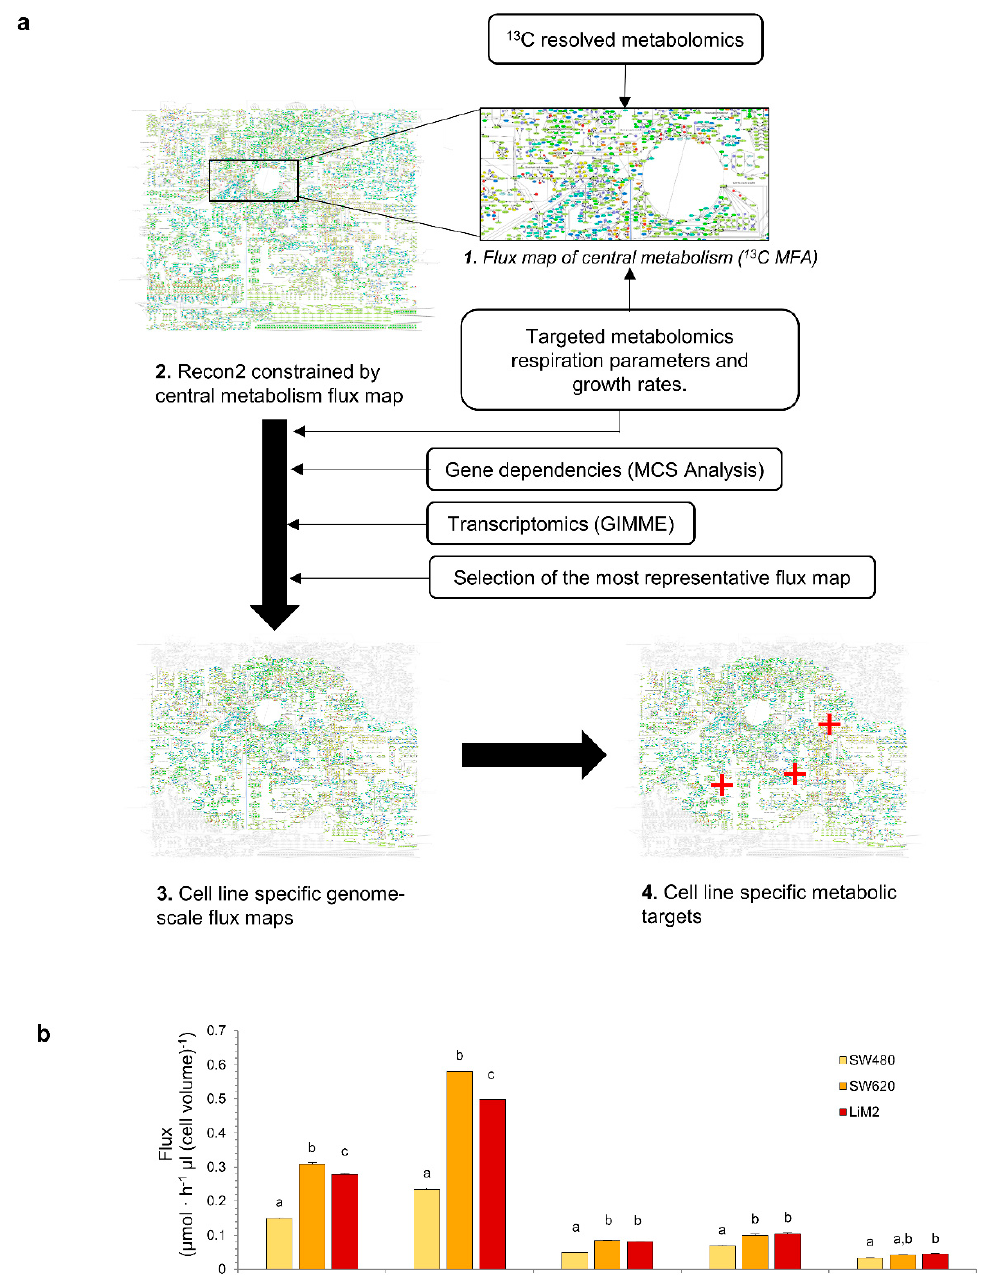
Figure 4. Computational inference of cell line-specific metabolic flux maps and metabolic targets through multiomics data integration. ( a ) Graphical representation of the multiomics integration workflow. First, a central carbon metabolism flux map is estimated using 13 C MFA, next the flux map is used to constrain the generic human GSMM Recon2, then several layers of omics data are used to estimate the cell line specific flux maps which can be used to identify metabolic vulnerabilities to selectively target specific populations. ( b ) Predicted Fluxes through HEX1 (hexokinase), LDH-L (lactate dehydrogenase), PDH (pyruvate dehydrogenase), CS (citrate synthase) and GLS (glutaminase). a–c denote cell lines with an overlap of the sampled flux values for a given reaction.